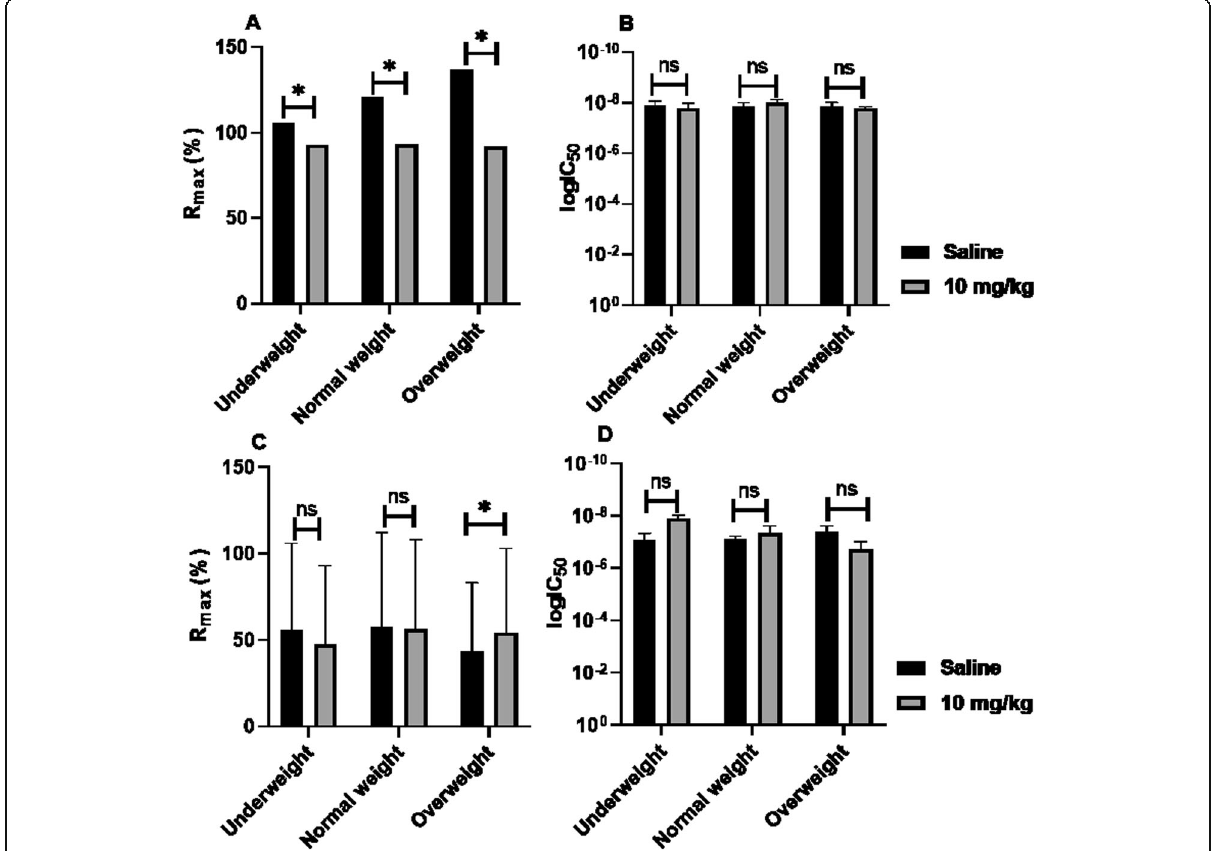
Fig. 6 Effect of peroxynitrite on ACh ( a and b ) and SNP ( c and d ) activity on isolated aortic rat rings exposed to saline and 10 mg/kg of LPS (treatments A and D). Graphs a and c show R max , and graphs b and d show logIC 50 means and SEM with the asterisk implying significant differences between the two treatments ( P < 0.05) and ns standing for the non-significant